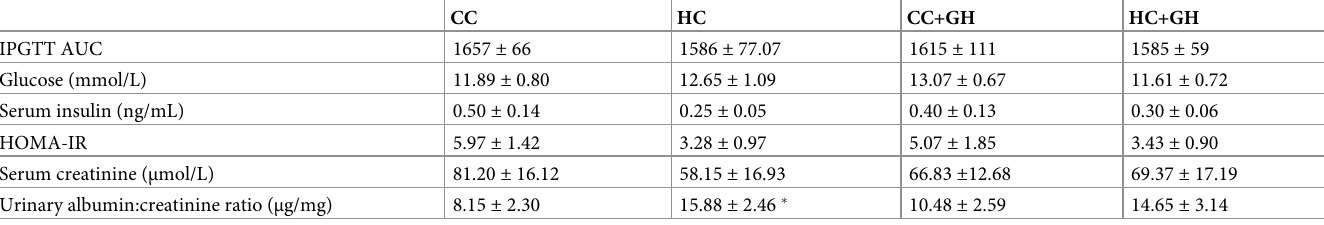
methylation (Fig 2A). Further, renal mRNA expression of DNA methyltransferases (DNMT)- 1 and DNMT3a were similar between offspring of obese, compared to lean, mothers. Hydral- azine administration to mothers during gestation did not significantly alter mRNA expression of DNMTs in offspring kidneys at week 9 (Fig 2B and 2C). There were no significant differ- ences between offspring groups in the mRNA expression of the enzyme ten-eleven-transloca- tion (Tet)-3 at week 9 (Fig 2D). Table 5. Metabolic parameters of week 32